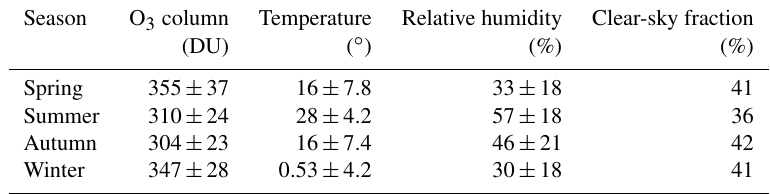
Table 1. O 3 column concentration, temperature, relative humidity, daytime clear-sky fraction and respective standard deviation for different seasons (spring: March, April, and May; summer: June, July, and August; autumn: September, October, and November; winter: December, January, and February).